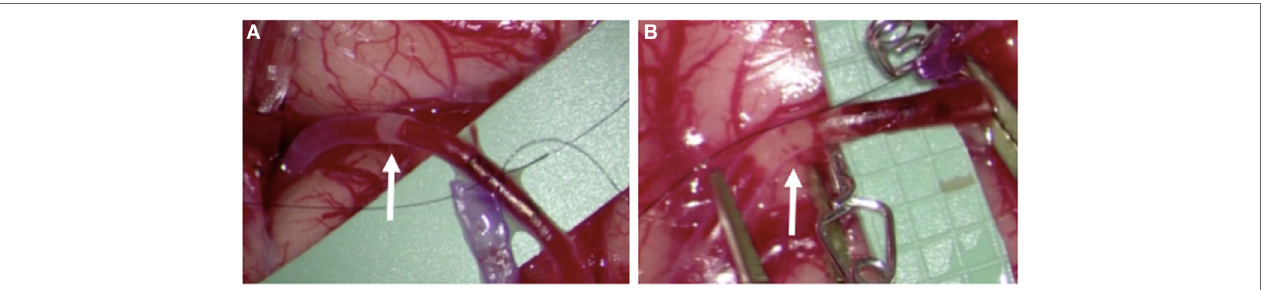
FiGURe 2 | Intra-operative photos taken during right superficial temporal artery–middle cerebral artery bypass of patient A, demonstrating intraluminal embolic material traveling in a distal-to-proximal direction, observed on two occasions (a,B) .